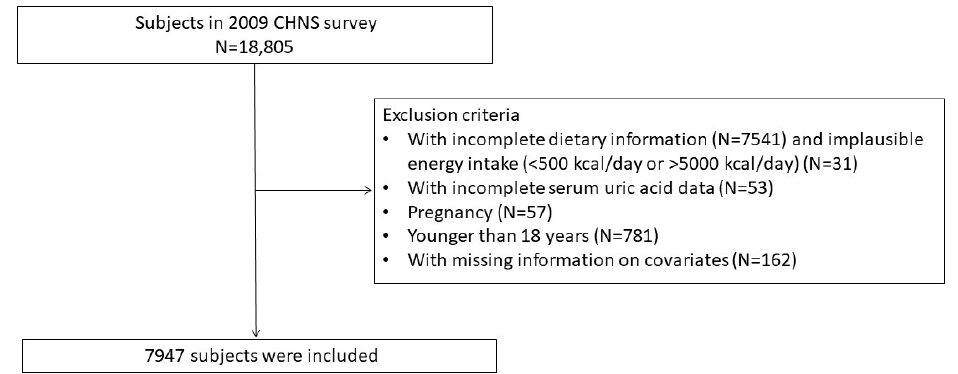
Figure 1. Flow chart of research participants selection.